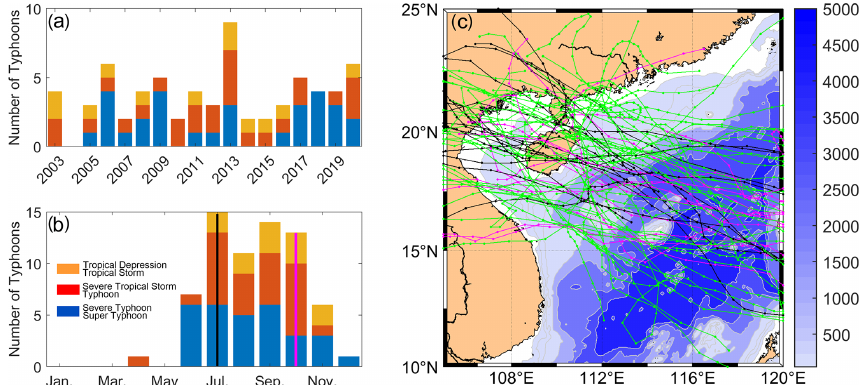
Figure 9. (a) Time series of the number of typhoons that passed by the study area during 2003–2020. (b) Seasonal distribution of typhoons. (c) Trajectories of typhoons during 2003–2020. The orange, red, and blue bars in (a–b) represent the numbers of tropical depressions and tropical storms, severe tropical storms and typhoons, and severe typhoons and super typhoons, respectively. The magenta and black curves in (c) represent the typhoons that passed by the study area in July and October, respectively. The green curves represent the typhoons that passed by the study area in the other